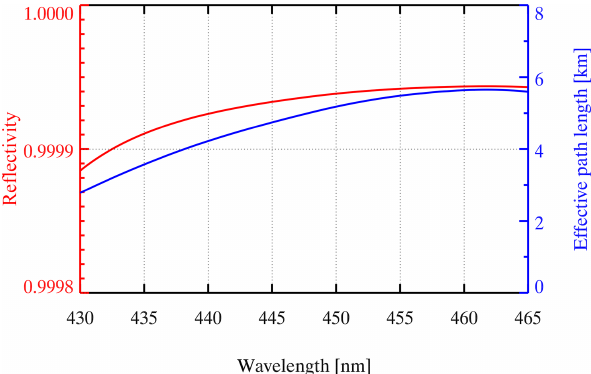
Figure 2. Mirror reflectivity and optical path length calibrated by He ( > 0 . 99999) and N 2 ( > 0 . 99999). The red line is the average R(λ) , and the blue line is the optical path length.